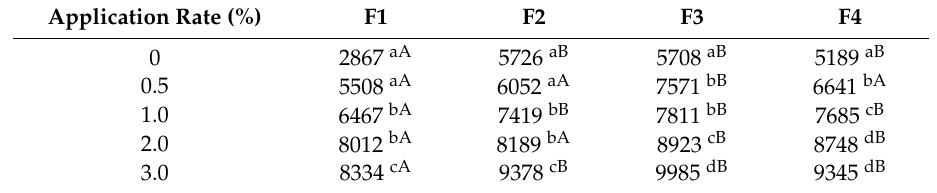
Table 5. Average maize production [kg / ha] in fields F1, F2, F3, and F4 at di ff erent application rates. Application Rate (%) F1 F2 F3